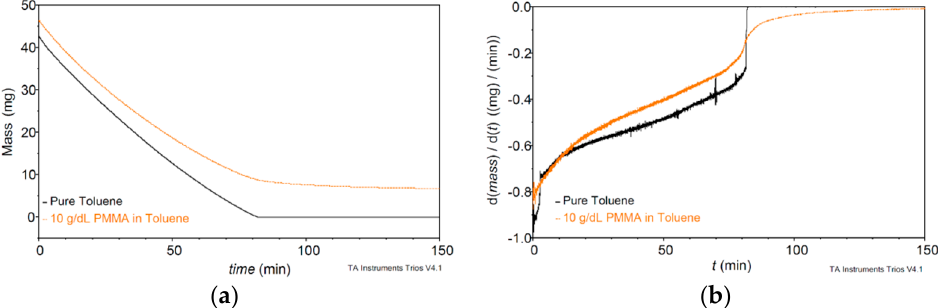
Figure 3. ( a ): TGA thermogram showing isothermal evaporation of pure toluene and a 10 g/dL PMMA–toluene solution under N 2 purge. Both solutions were monitored until dry. The residue mass in the 10 g/dL PMMA curve represents the dried polymer. ( b ): Derivative TGA thermogram of solvent and polymer solution at ambient temperature with respect to polymer mass fraction.